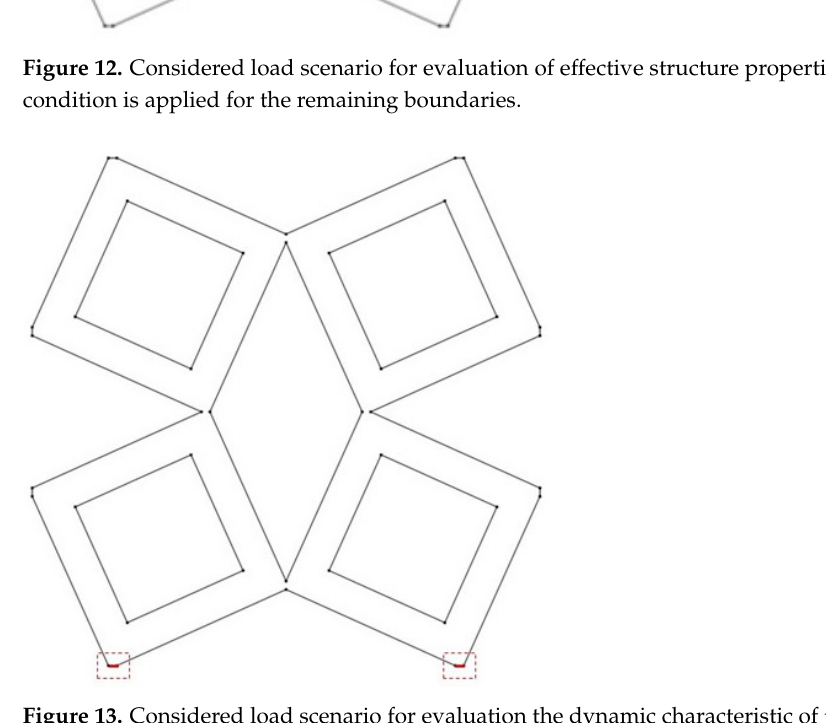
Figure 13. Considered load scenario for evaluation the dynamic characteristic of the structure. Free boundary condition is applied for the remaining boundaries.